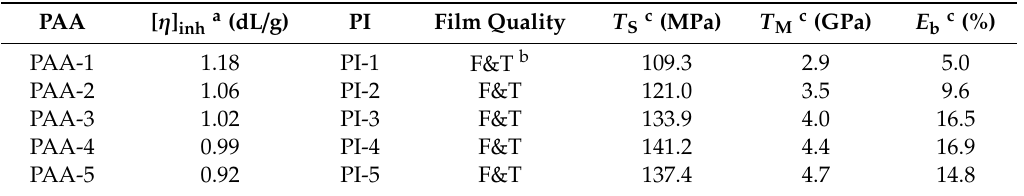
Table 1. Inherent viscosities of poly(amic acid) (PAA) solutions and mechanical properties of the polyimide (PI)